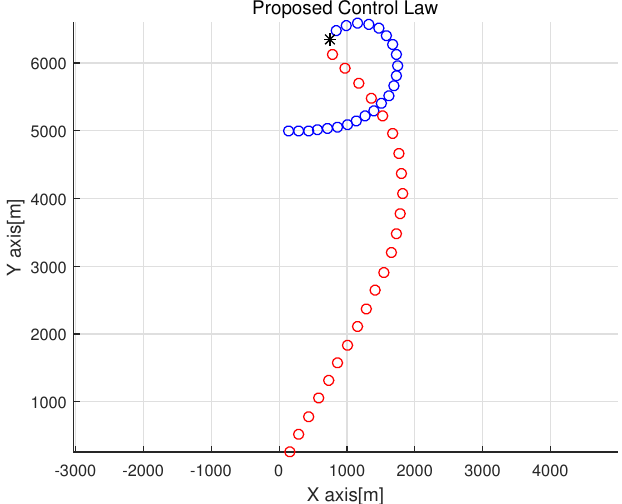
Figure 7. We set the evader’s speed as v e = 70 + 30 × sin( T × k × 0.01) in m/s. In addition, the evader k maneuvers using u e = 0.005 × sin( T × k /100). k